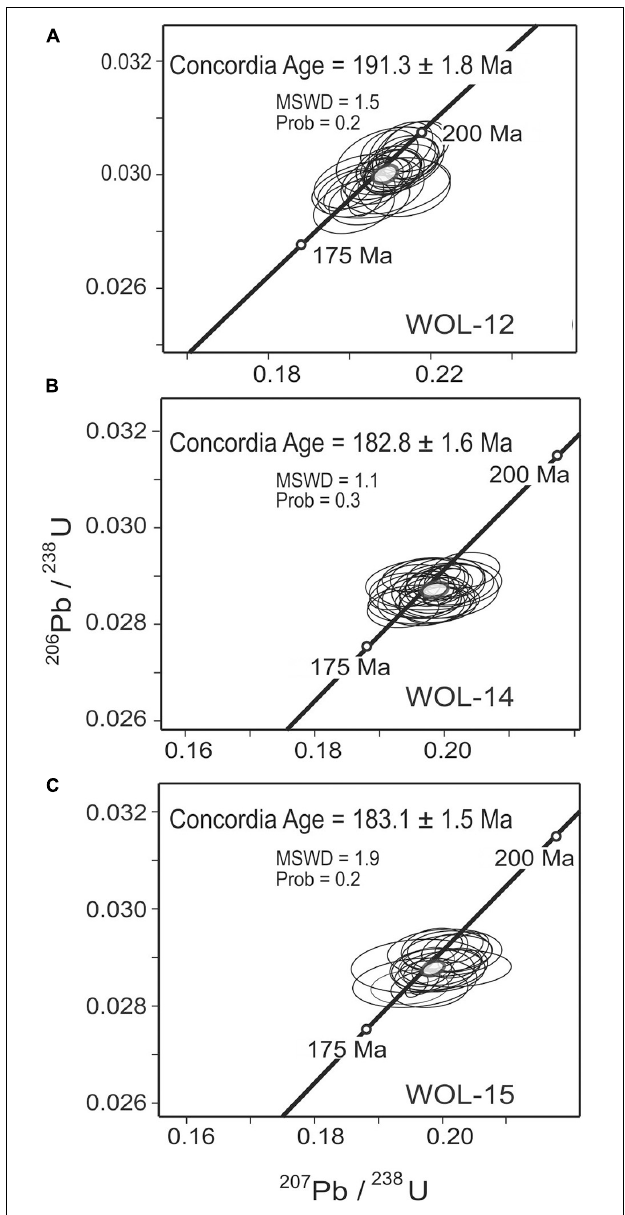
FIGURE 5 | Concordia diagrams with U-Pb isotopic data of studied samples (A) WOL-12, (B) WOL-14, and (C) WOL-15. All ages are quoted with 2 σ